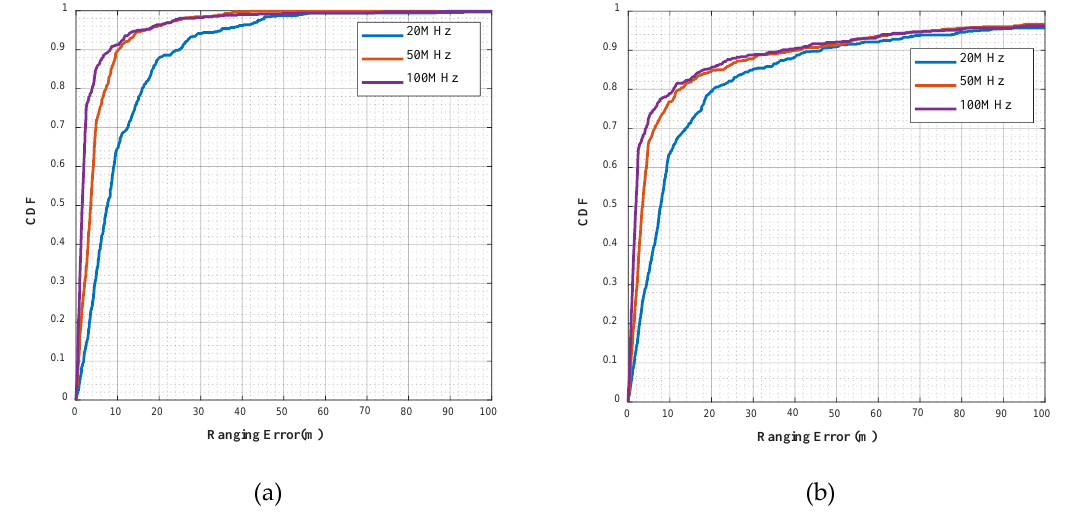
Figure 7. ( a ) CDF of the NC-MUSIC ranging error in UMi scenario with 20 MHz, 50 MHz and 100 MHz bandwidth; ( b ) CDF of the NC-MUSIC ranging error in UMa scenario with 20 MHz, 50 MHz and 100 MHz bandwidth.